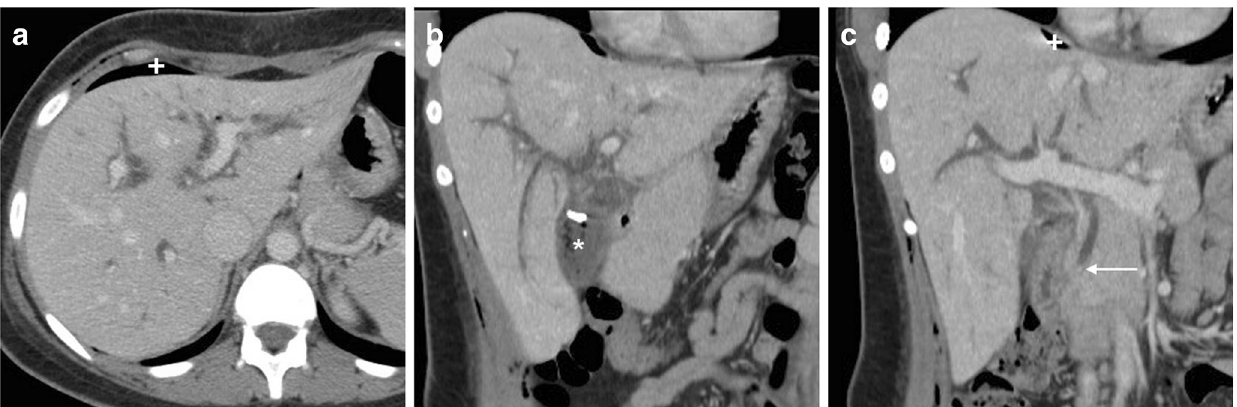
Fig. 16 Residual lithiasis and cholangitis after laparoscopic cholecystectomy, developing despite preoperative ERCP. On the 6th postoperative day, CT ( a – c ) showed residual intraperitoneal air (+ in a ), usual collection at gallbladder fossa (* in b ), B mottled ^ liver parenchymal